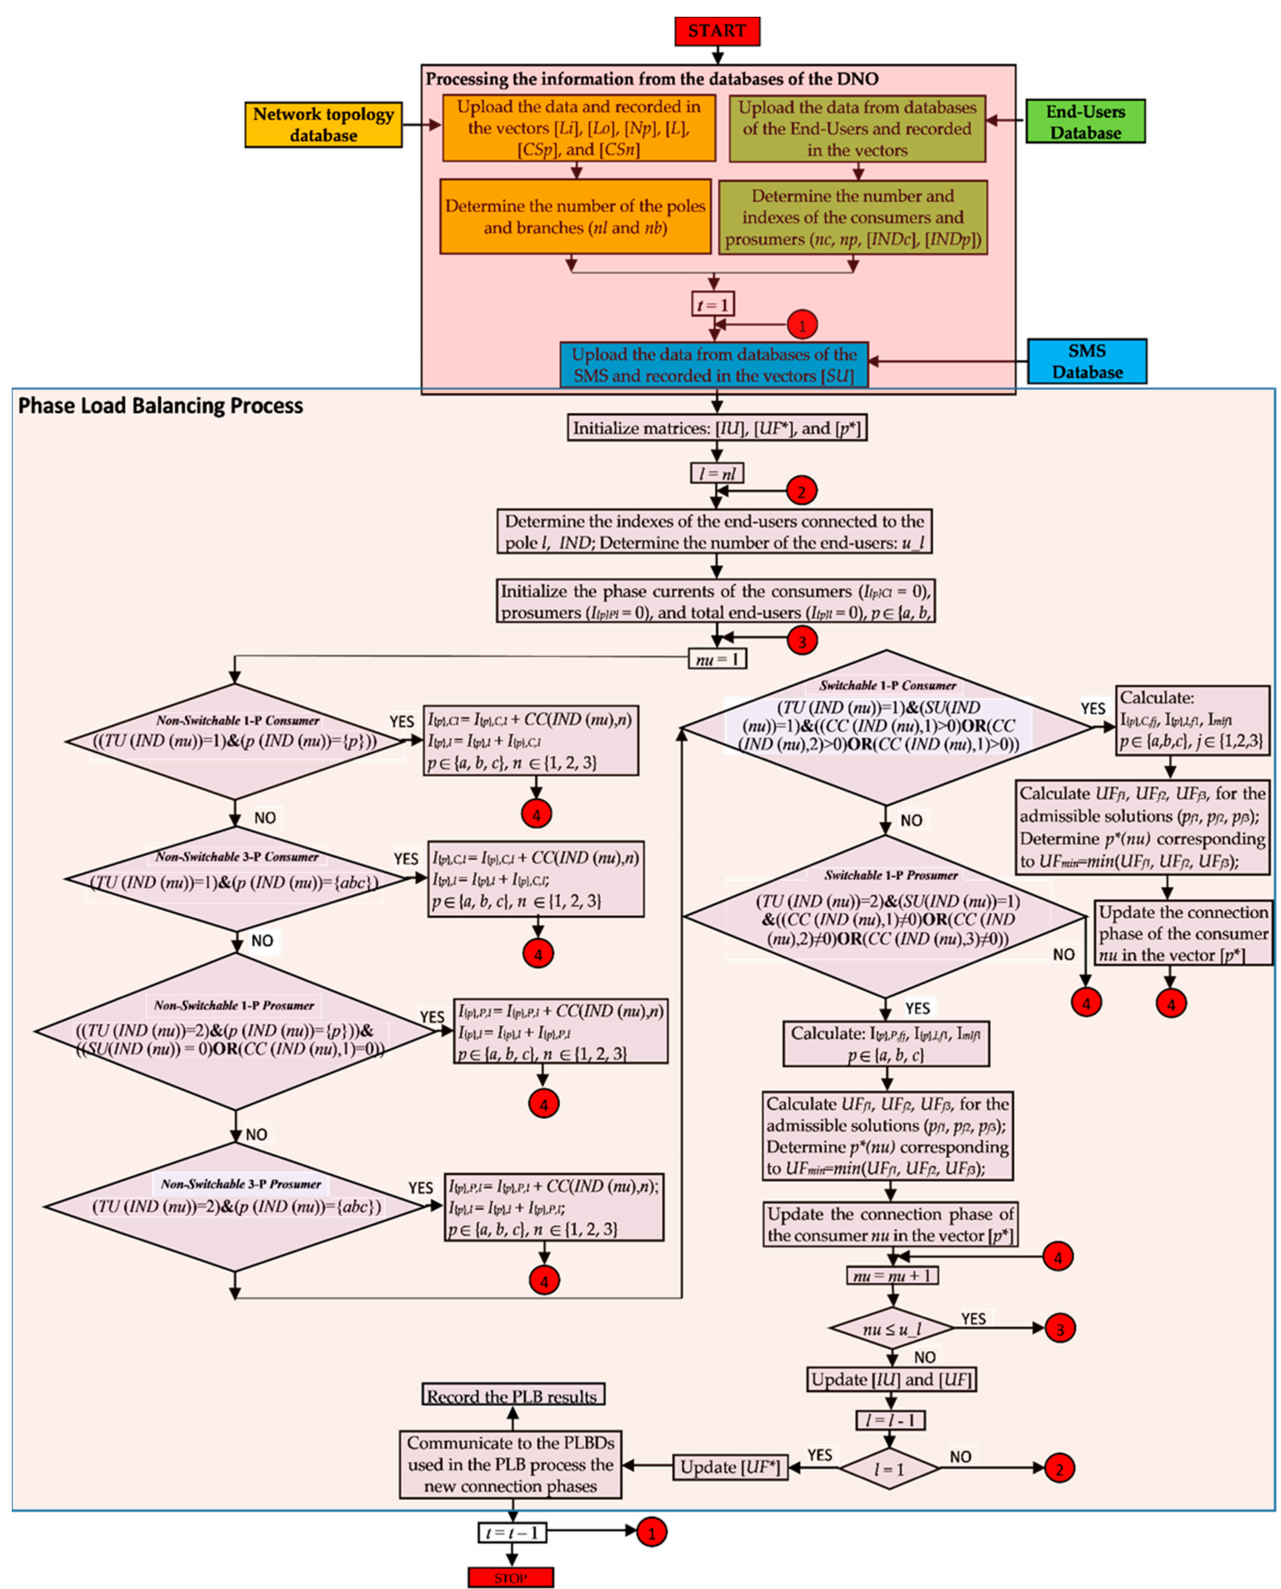
Figure 8. The flow-chart of the proposed coordinated control algorithm of 1-P end-users for phase load balancing in the